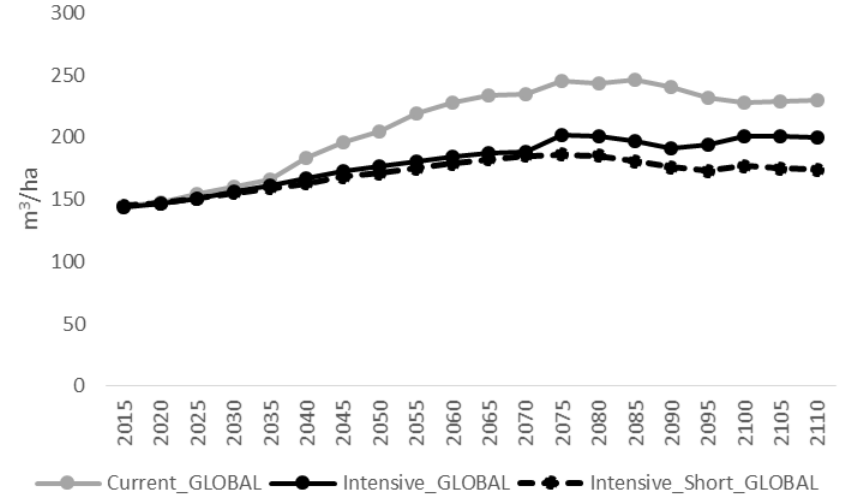
Figure 12. Projected average standing volumes of living trees on productive forestland ( > 1 m 3 ha − 1 year − 1 ) with current forest management approaches of different intensities in the GLOBAL BIOENERGY scenario.